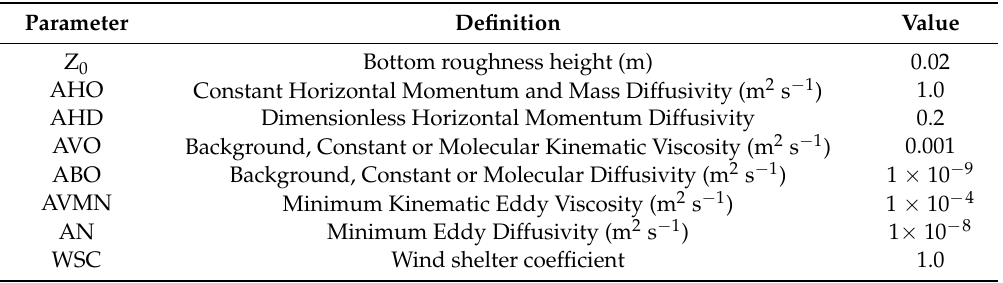
Table 2. Main parameters of hydrodynamic